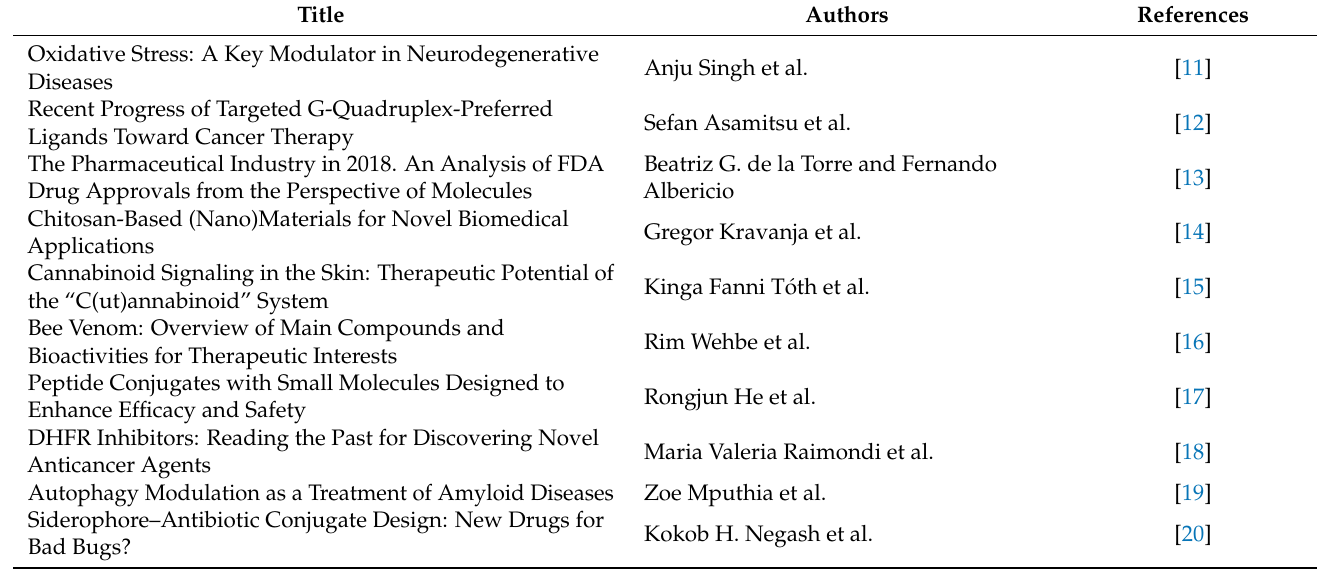
Table 2. The top 10 review articles of 2019 in the Medicinal Chemistry section of